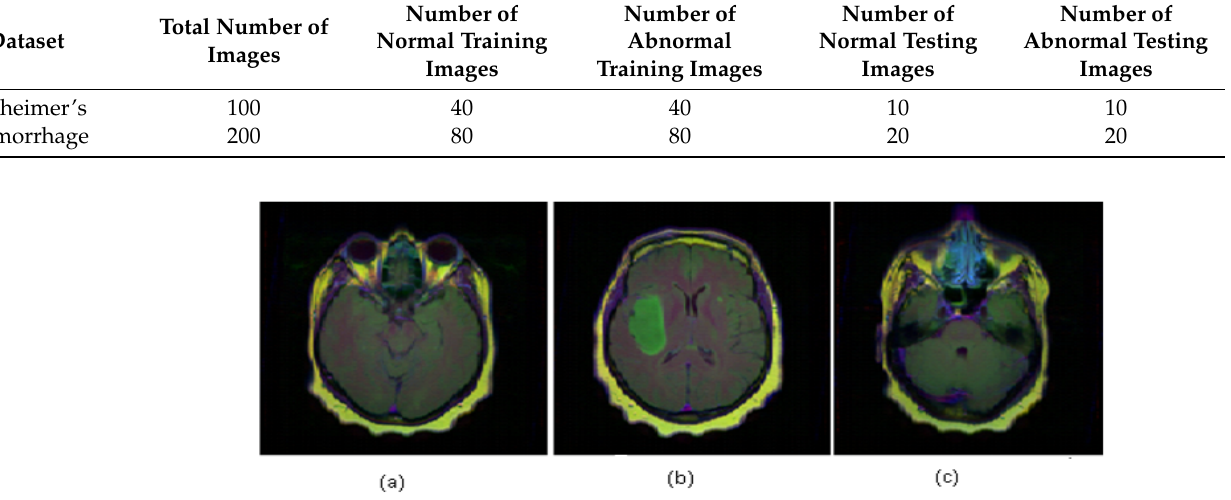
Figure 3. Samples of brain MR image: ( a ) Normal MRI. ( b ) Alzheimer’s disease. ( c ) Hemorrhage’s